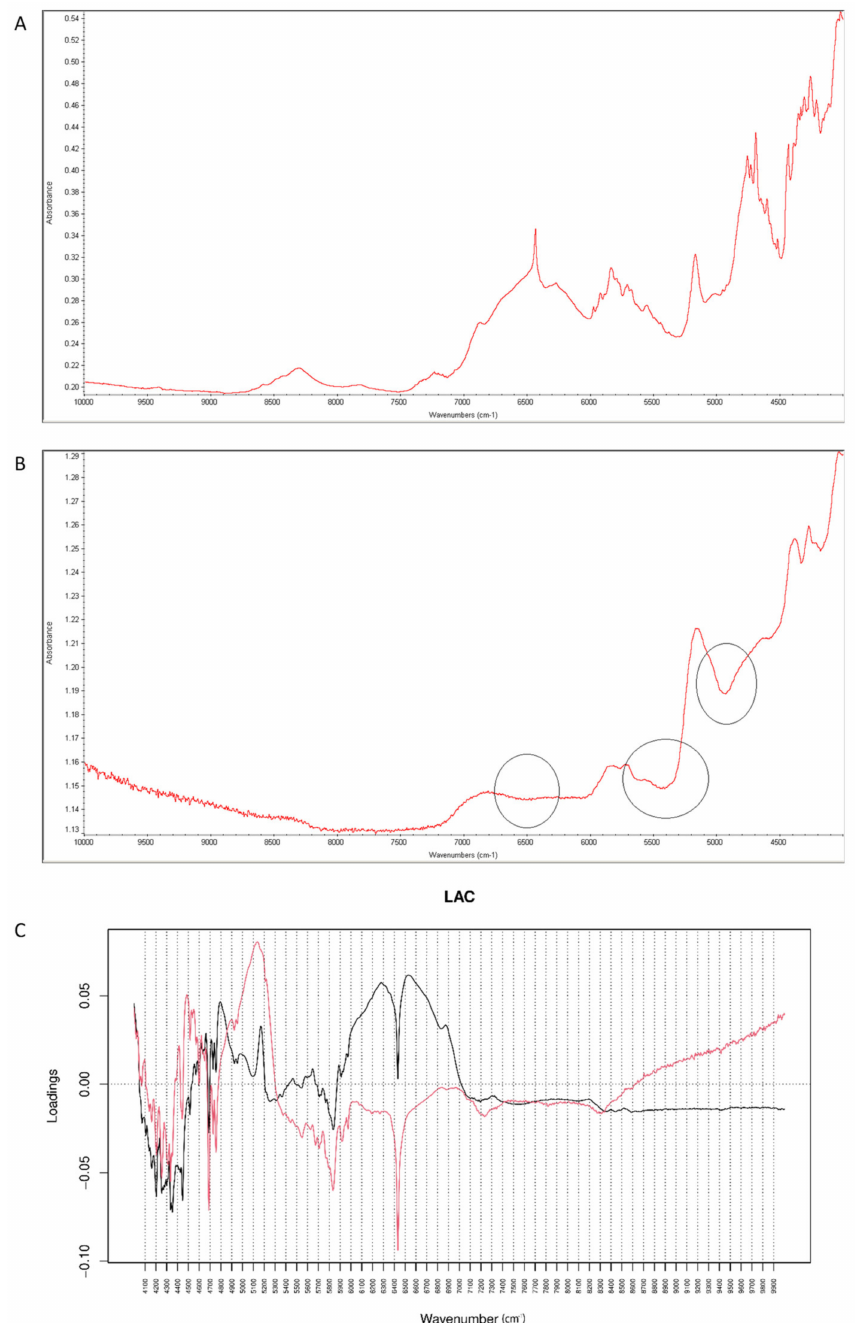
Figure 13. ( A – C ) Vildagliptin and lactose (LAC): NIR spectra of no stressed mixture ( A ), stressed mixture ( B ) and PCA loadings of the spectra ( C ); PC1 loadings are marked black while PC2 loadings are marked red; most visible differences in the spectrum of the stressed mixture are indicated with